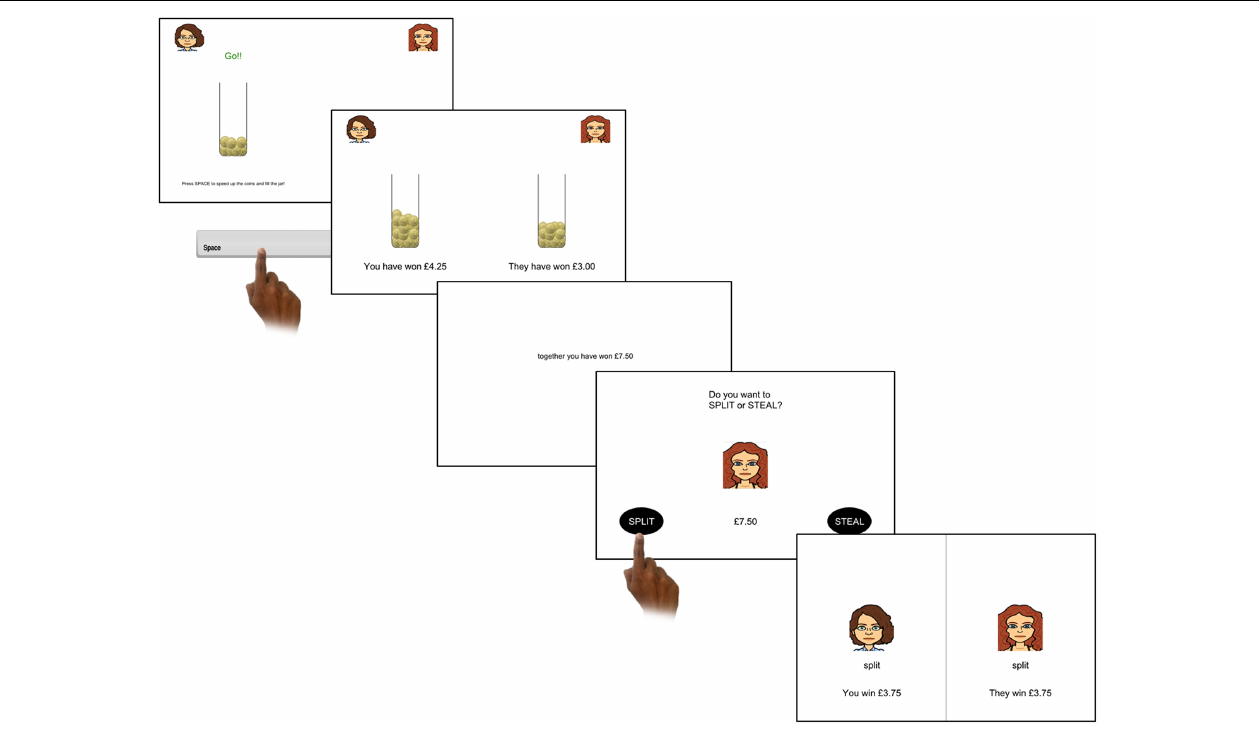
FIGURE 2 | One trial of the Prisoner’s Dilemma. First, participants repeatedly pressed the spacebar as fast as possible; the more presses they completed the quicker the jar filled with coins. Participants then received feedback showing how much they and their computer opponent had contributed, and a subsequent screen showed the total combined earnings. Then participants made the decision to split or defect this combined pot. In this trial the participant and the computer both decided to split and so the earnings were split